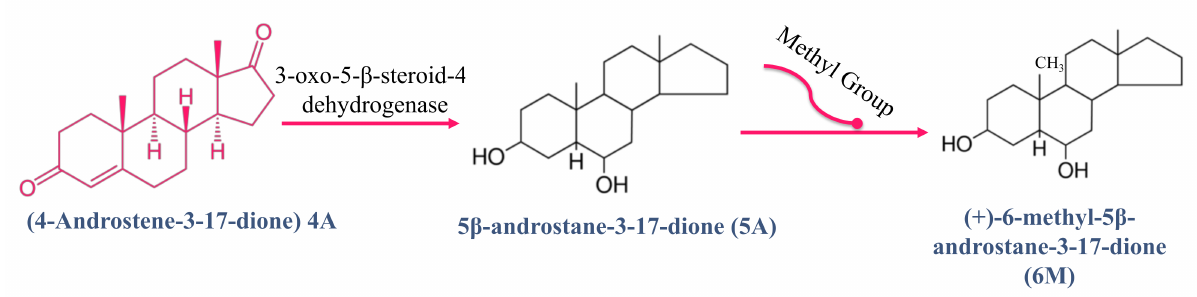
Figure 3. The chemical equation of the enzyme-catalyzed reaction of 4-androstene-3-17-dione (4A) hormone with 3- oxo-5- β -steroid-4- dehydrogenase enzyme to produce 5 β -Androstane-3-17-dione (5A), followed by the production of (+)-6-methyl-5 β -androstane-3-17-dione (6M) with a methyl group attached at the C6 position